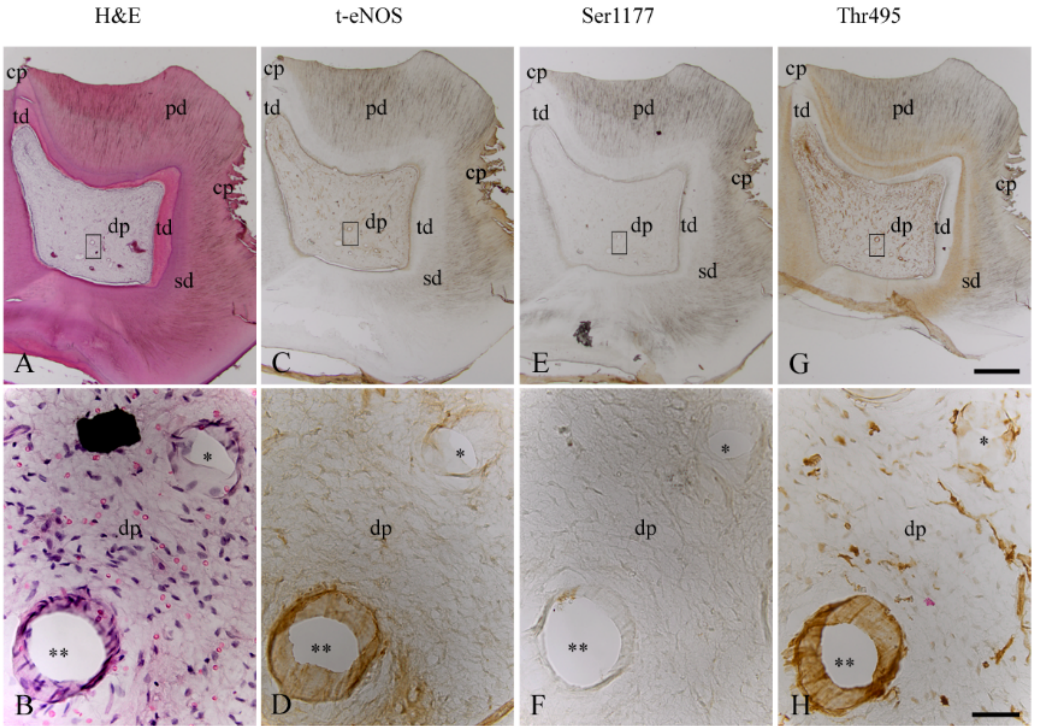
Figure 4. H&E staining and localization of t-eNOS, Ser1177, and Thr495 in blood vessels of the inflamed dental pulp of a human third molar. In the inflamed dentin–pulp complex, occlusal and approximal carious lesions (cp), primary dentin (pd), secondary dentin (sd), and tertiary dentin (td) areas are visible ( A ). In the detailed image of the region drawn with a rectangle in A, the venous (one asterisk) and arterial (two asterisks) blood vessels and inflammatory cells in the dental pulp (dp) are seen ( B ). In the same venous (asterisk) and arterial (two asterisks) blood vessels of the consecutive sections of the inflamed human dental pulp, eNOS ( C , D ) with moderate staining intensity, Ser1177 ( E , F ) with very weak staining intensity, and Thr495 ( G , H ) with strong staining intensity are detected. Odontoblasts of the inflamed dental pulp reveal localizations for eNOS ( C ) and Thr495 ( G ) but not for Ser1177 ( H ). In some subpopulations of the inflammatory dental pulp cells, eNOS ( C , D ) and Thr495 ( G , H ) are visible at different staining intensities. Scale bars: A,C,E,G = 1 mm; B,D,F,H = 50 µm.